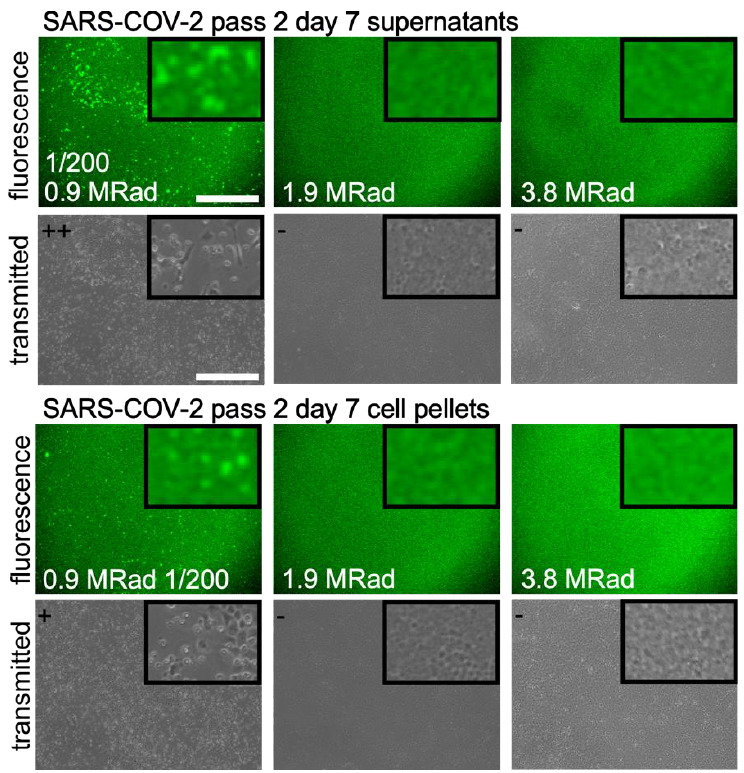
Figure 3. Inactivation of SARS-CoV-2 by gamma radiation. Supernatants were collected from the primary culture flasks after 7 days post infection and used to inoculate fresh cells. Images were taken after an additional 7 days. For the 0.9 MRad dose, undiluted samples caused excessive cell death by day 7 and poor image quality. So, an image for culture medium diluted 1/200 is shown for this dose only with other samples being undiluted. Insets are 5× magnification of the parent image. At top left of brightfield images grading for CPE is given with - = none, + = low and ++ = high CPE. Scale bar is 500 mm with all images taken at the same magnification.